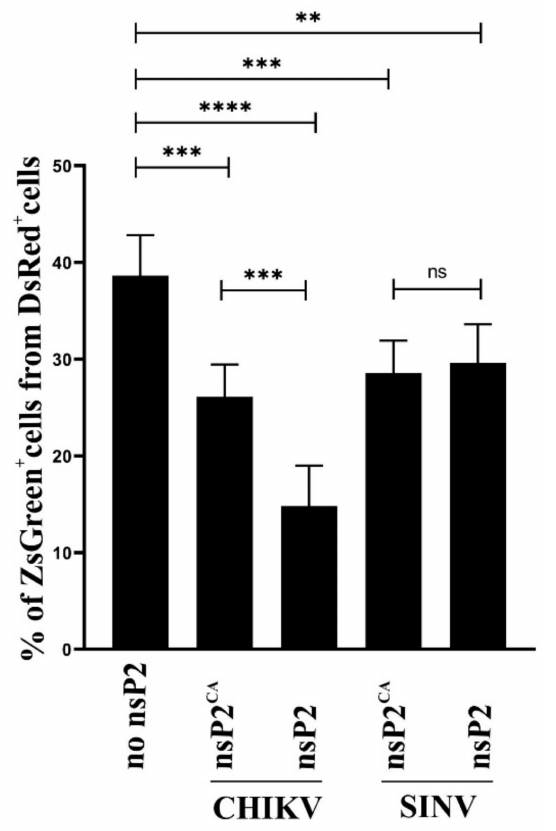
Figure 3. Efficiency of infection of C6/36 cells by CHIKV VRPs is reduced by expression of CHIKV or SINV nsP2 proteins. C6/36 cells grown in 12-well plates were transfected with pB-IE1.dsR (no nsP2), pPubi-CHIKV-nsP2 CA , pPubi-CHIKV-nsP2, pPubi-SINV-nsP2 CA or pPubi-SINV-nsP2. At 48